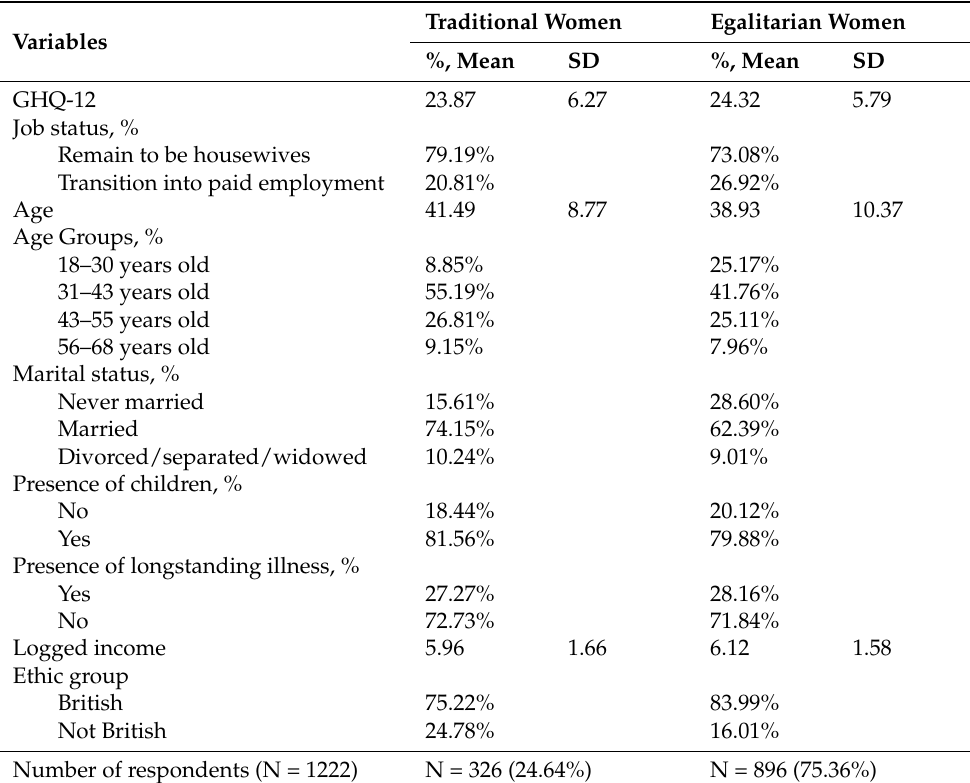
Table 1. Weighted sample descriptive